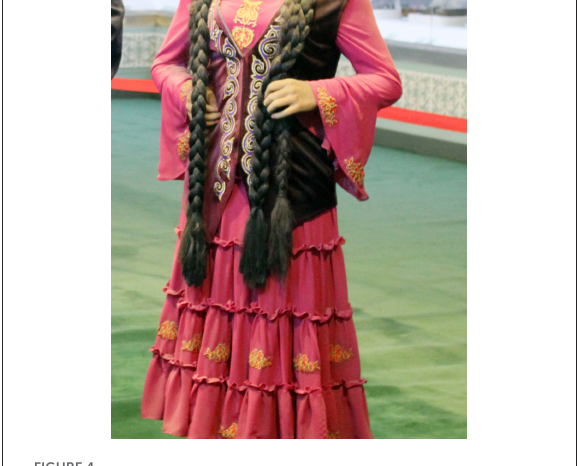
FIGURE4 Garment in Kazakh.